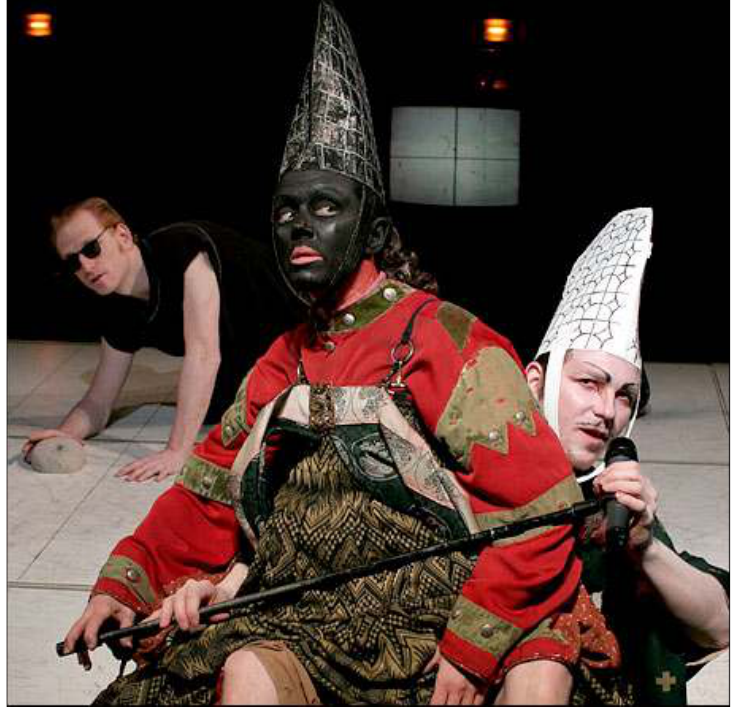
Figure 4: Scott Shepherd, Kate Valk and Ari Fliakos in The Wooster Group’s The Emperor